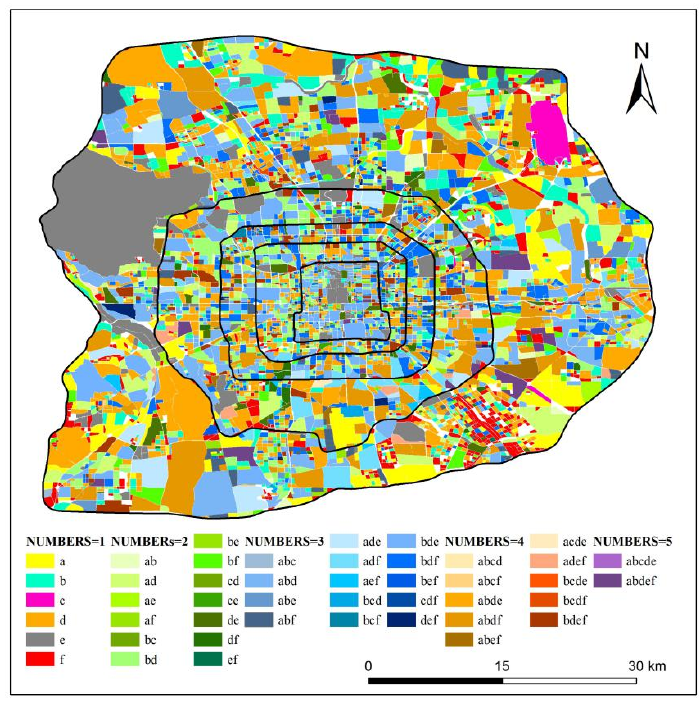
Figure 3. Land use data in the study area. (Note: a—industrial land, b—public management and service facilities land, c—transportation facilities land, d—residential land, e—green space and square land, f—commercial service land).